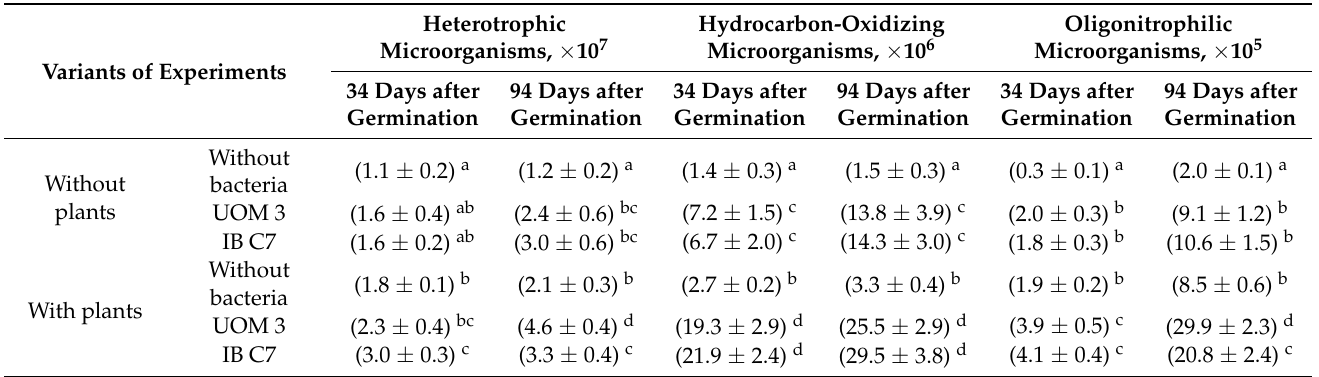
Table 3. The number of microorganisms in the oil-contaminated soil,